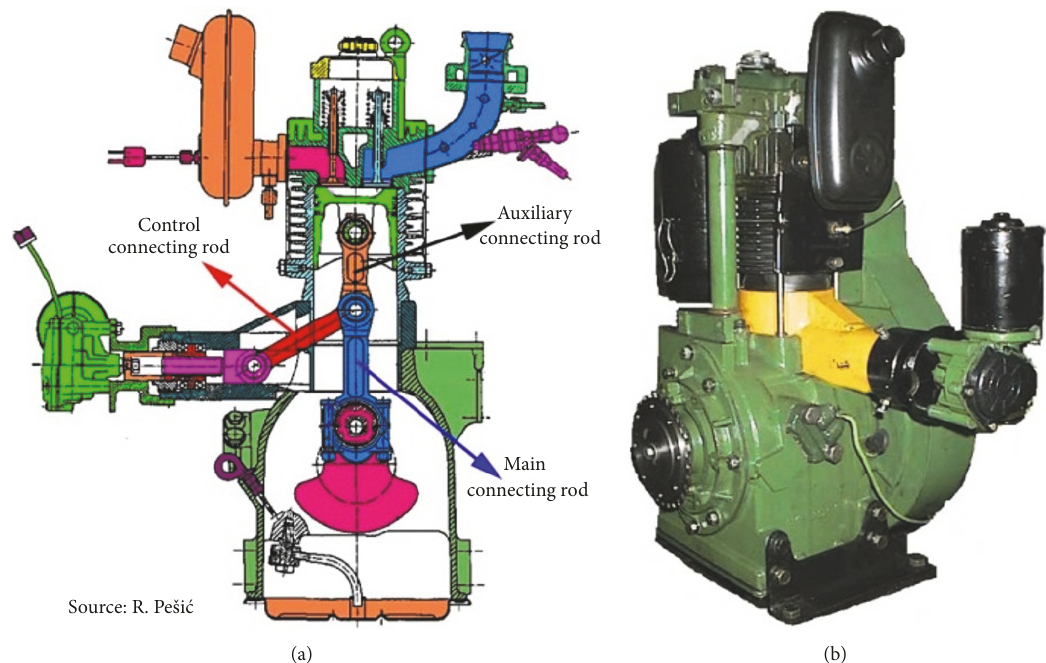
Figure 2: (a) Cross section and (b) photography of the experimental engine with VCR mechanism.